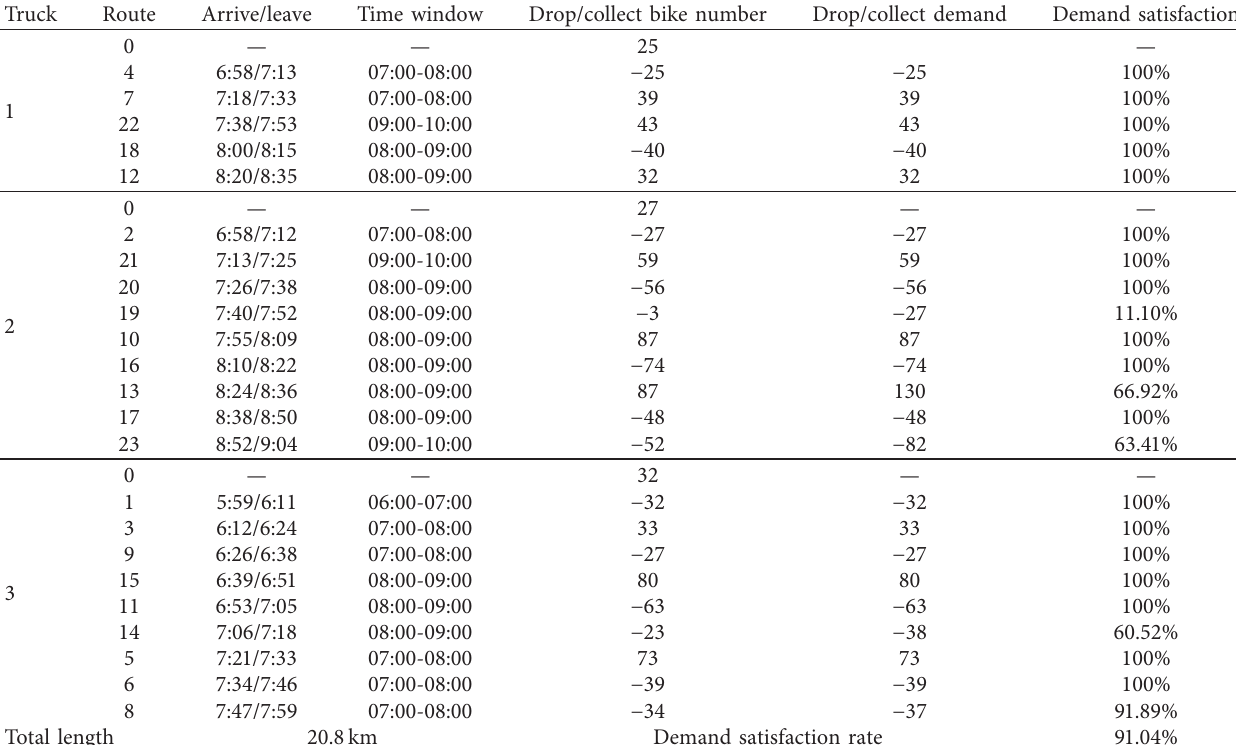
Table 6: The routes of the truck and details of operation and time at the demand